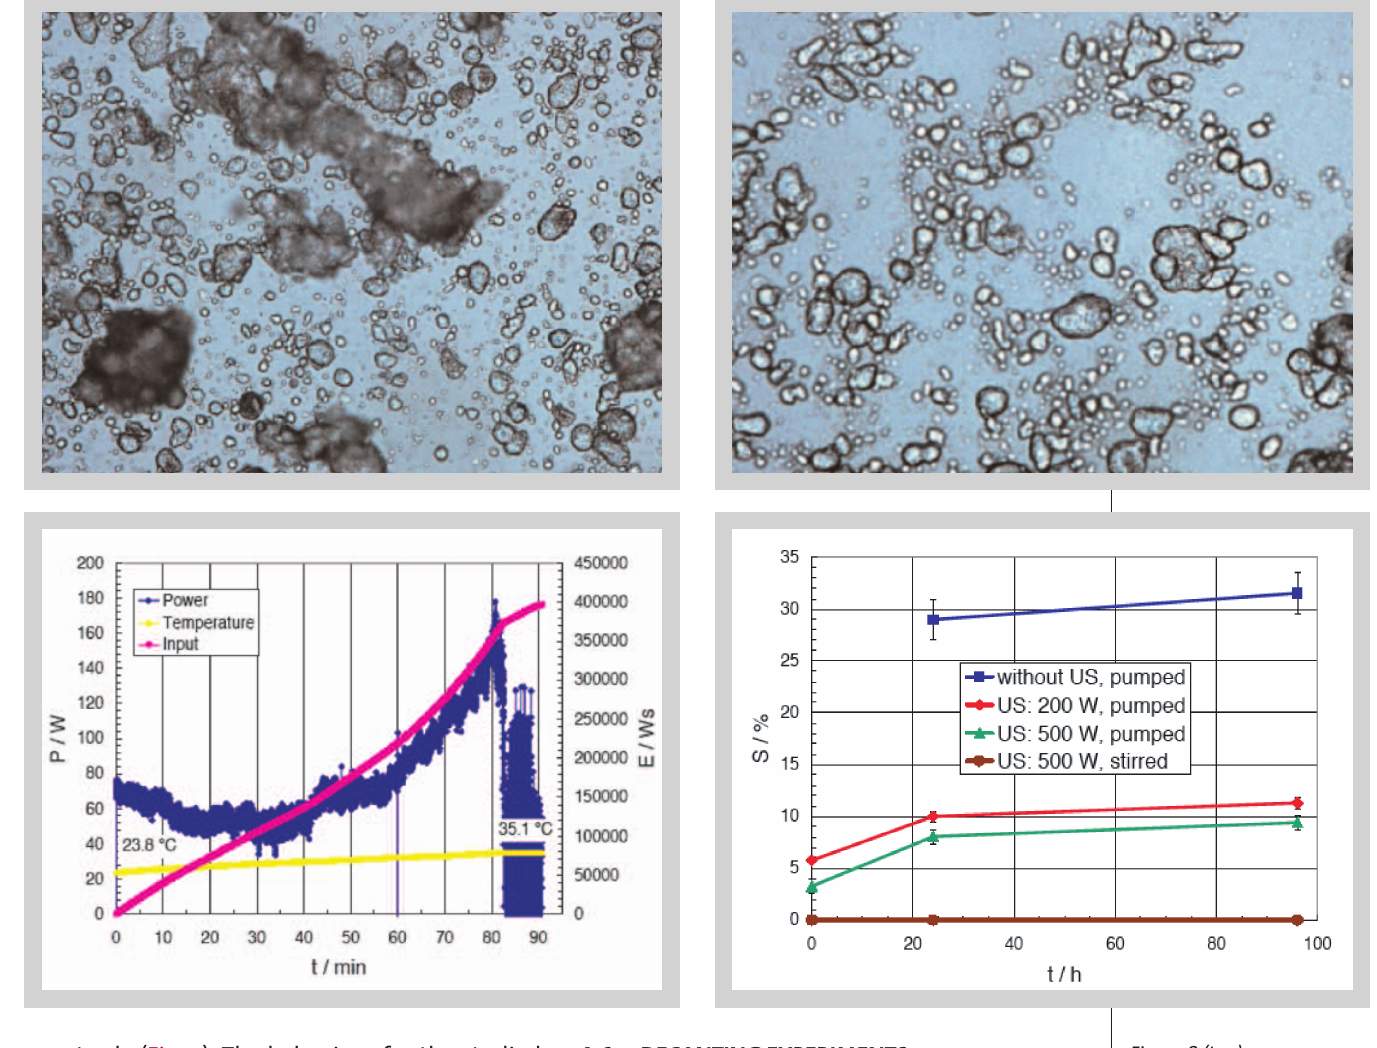
Figure 8 (top): Light microscopic images of Pural®SB-water mixture (F = 56.5 %, diluted to 0.1 %): left:(a) only stirred (160 g mixture, 200 rpm) and (b) V· pumped with a flow rate = 4 l/min, Pmax = 500 W (right). Figure 9 (below left): Ultrasonic power input dur- ing the pump experiments (V· = 4 l/min): F = 56.5 %, Pmax = 200 W. Figure 10 (below right): Decanting experiments for suspensions with F = 56.5 %: (V· (a) pumped = 4 l/min, 4600 g mixture): Pmax = 0, 200 and 500 W, (b) only stirred (160 g mixture, 200 rpm): Pmax = 500